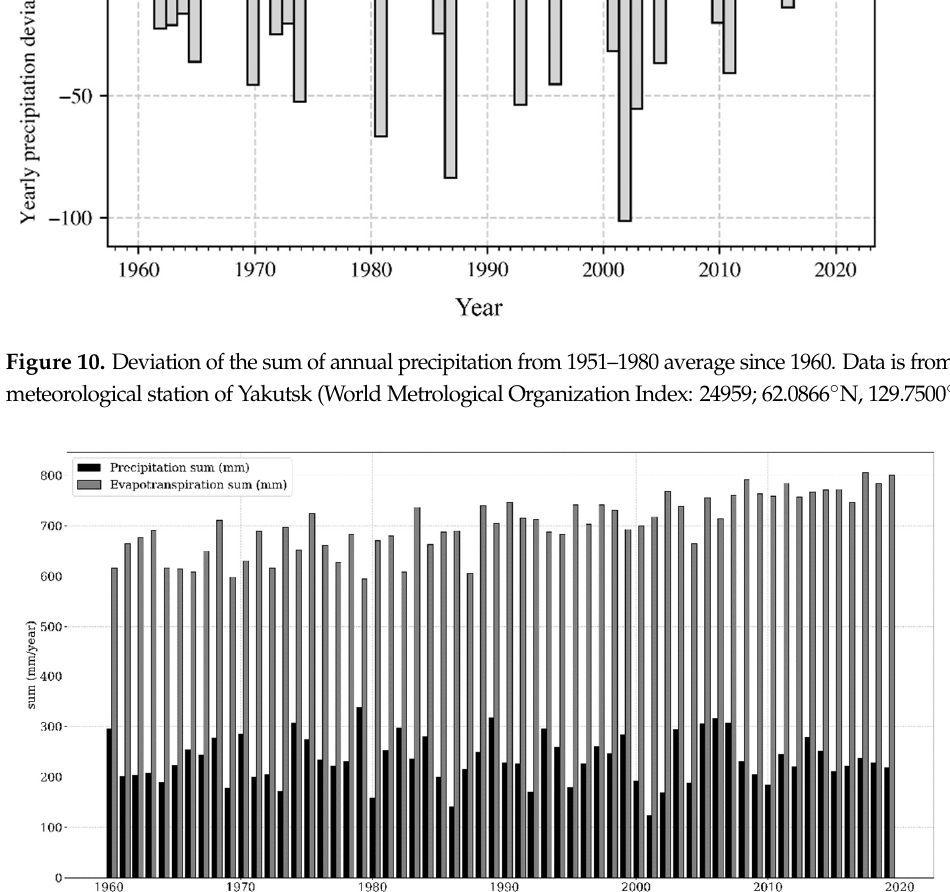
Figure 11. Comparison of the yearly sum (mm) of evapotranspiration (calculated using the Blaney- Criddle method) and precipitation (mm) (Data is from the meteorological station of Yakutsk (World Metrological Organization Index: 24959; 62.0866°N, 129.7500°E)).